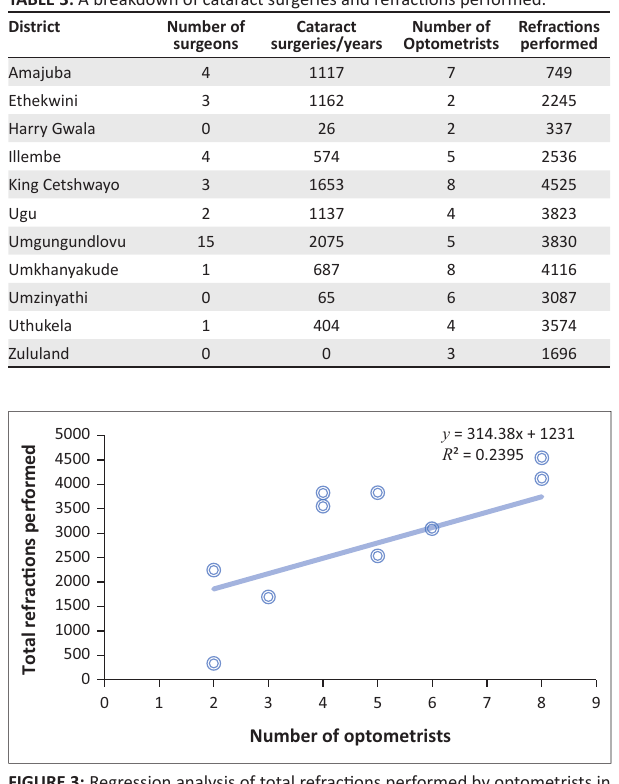
FIGURE 3: Regression analysis of total refractions performed by optometrists in KwaZulu-Natal. TABLE 4: The main themes that were identified as general comments by various types of human resources for eye health that were present in the eye clinic during data collection. HReH category Shortage of equipment Increased workloads Shortage of other resources Training and other matters Optometrists (3)